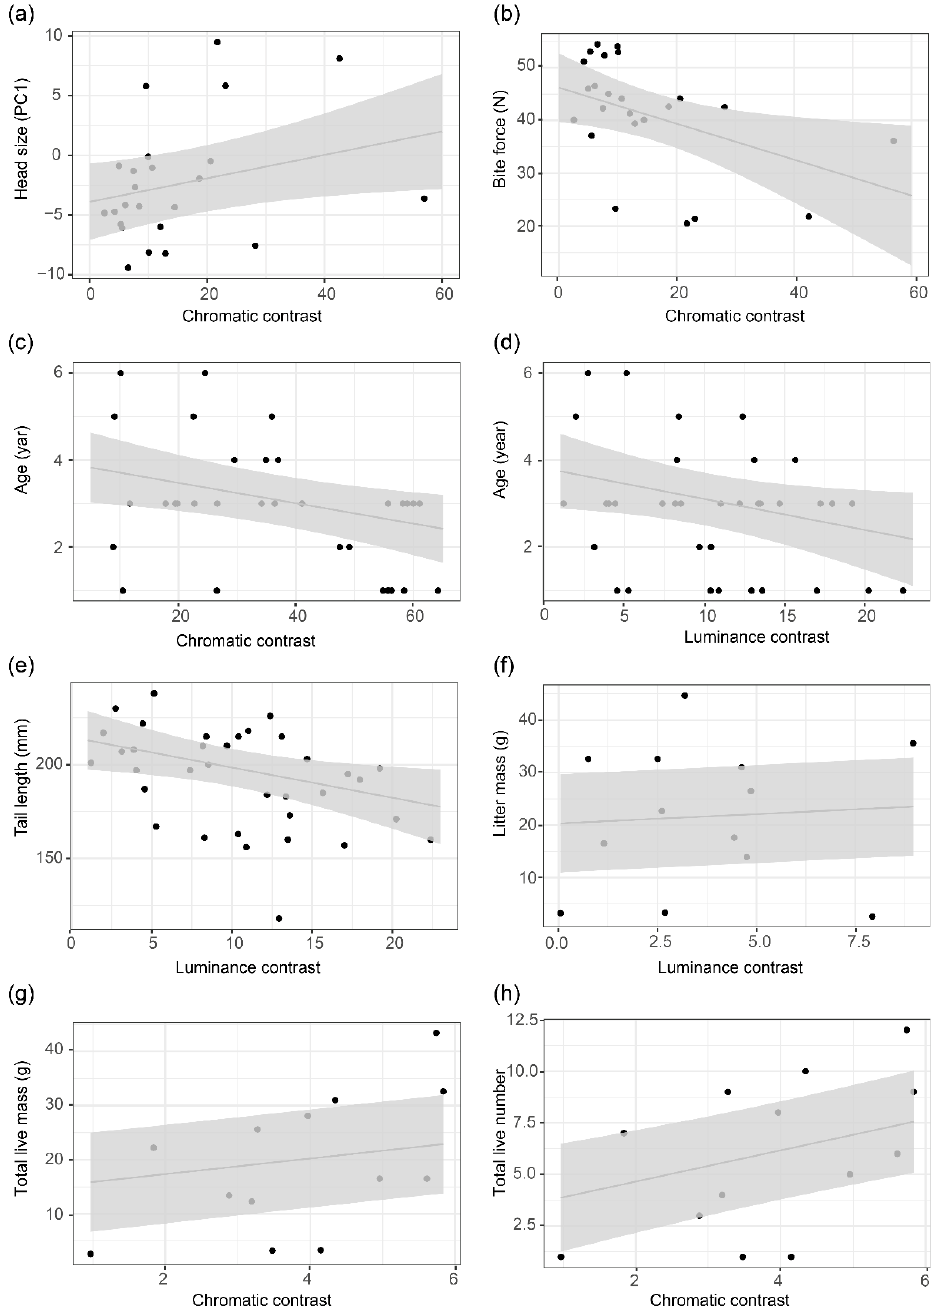
Figure 6. Relationship between phenotypic traits, reproductive output, and conspicuousness of colour patch in just-noticeable differences (JNDs) in relation to a lizard visual system for chromatic and luminance channels against a common vegetation background. ( a ) Chromatic contrast in throat colour of males in relation to head size (PC1); ( b ) chromatic contrast in throat colour of males in relation to bite force; ( c ) chromatic contrast in throat colour of females in relation to individual age; ( d ) luminance contrast in throat colour of females in relation to individual age; ( e ) tail length and luminance contrast in throat colour of females; ( f ) luminance contrast in ventral colour of males in relation to the litter mass of the offspring they sired; ( g ) chromatic contrast in ventral colour of males in relation to the total live mass of the offspring they sired; ( h ) chromatic contrast in ventral colour of males in relation to total live number of the offspring they sired. Grey line means the predicted phenotypic value against conspicuousness of colour patch based on linear mixed model and grey area represents the 95% confidence